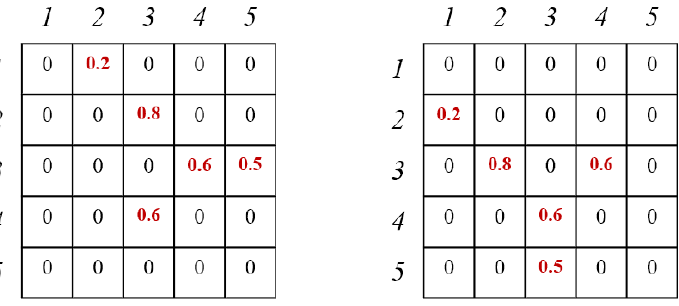
Figure 4. Out-degree and in-degree